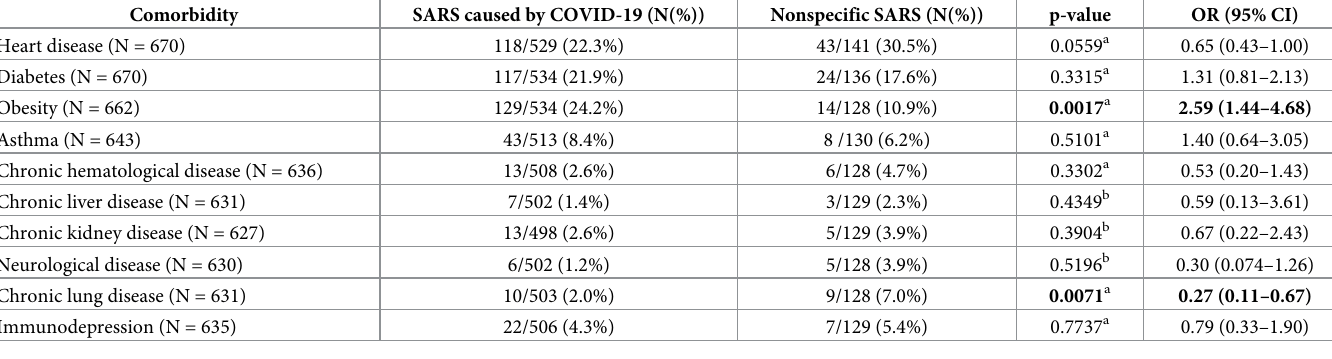
Table 2. Frequency of comorbidities in pregnant and postpartum women who died from SARS according to the cause (COVID-19 or nonspecific).